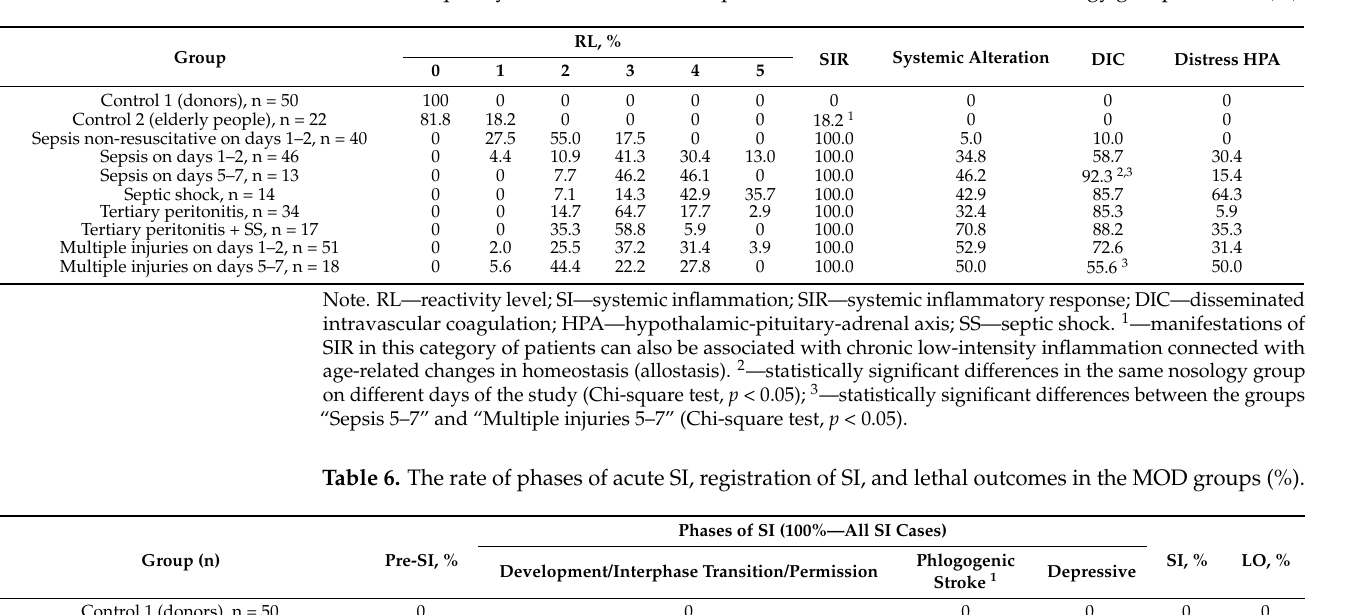
Table 5. Frequency of different RL and SI phenomena values in the acute nosology groups studied (%).